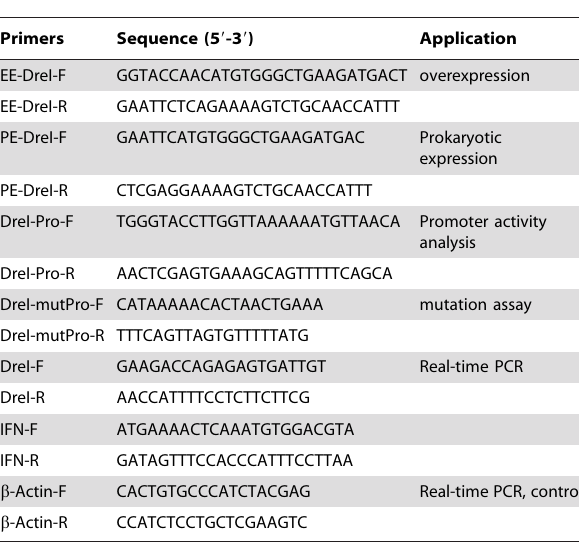
Table 1. Primers used in this